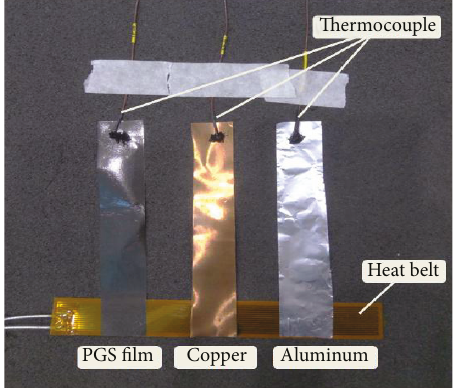
Figure 5: Qualitative test of thermal conductivity.